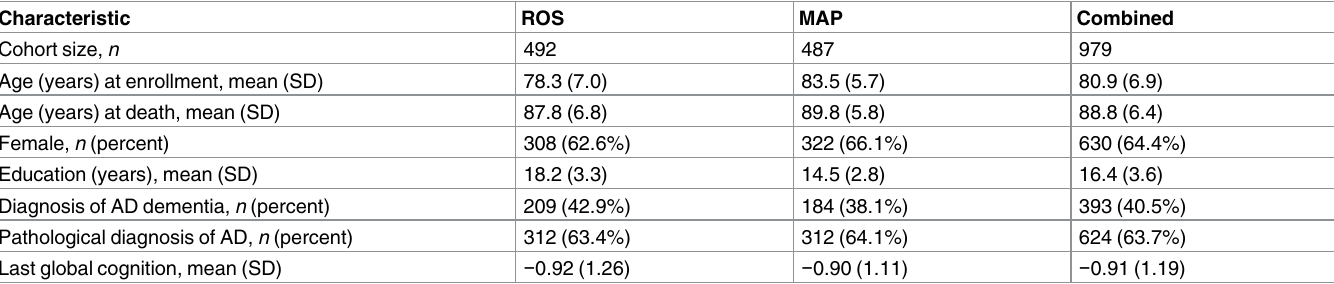
Table 1. Demographic characteristics of